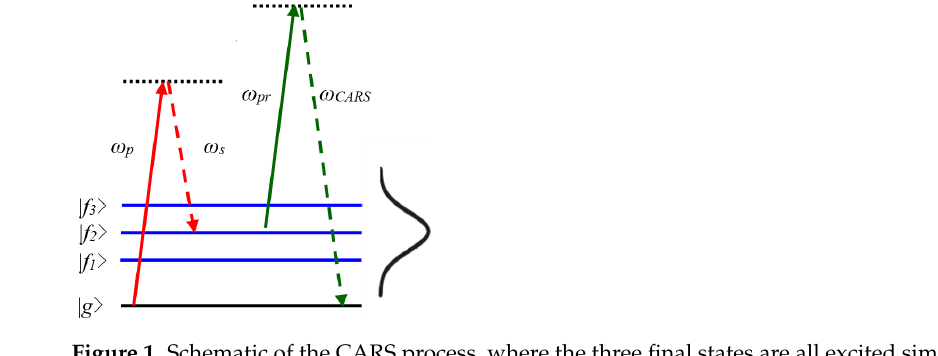
Figure 1. Schematic of the CARS process, where the three final states are all excited simultaneously by the pump field E p , the Stokes field E s , and the probe field E pr .